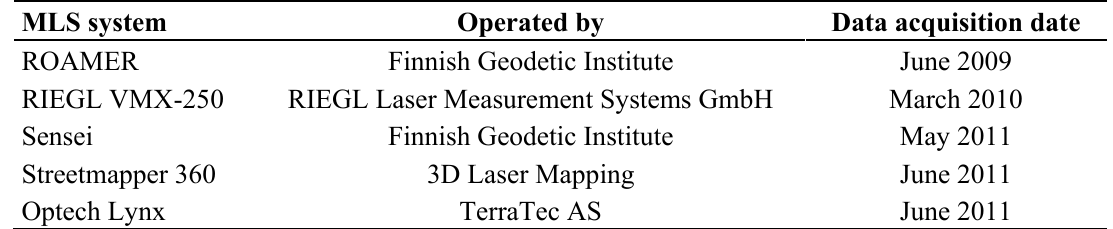
Table 1. The tested MLS-systems.